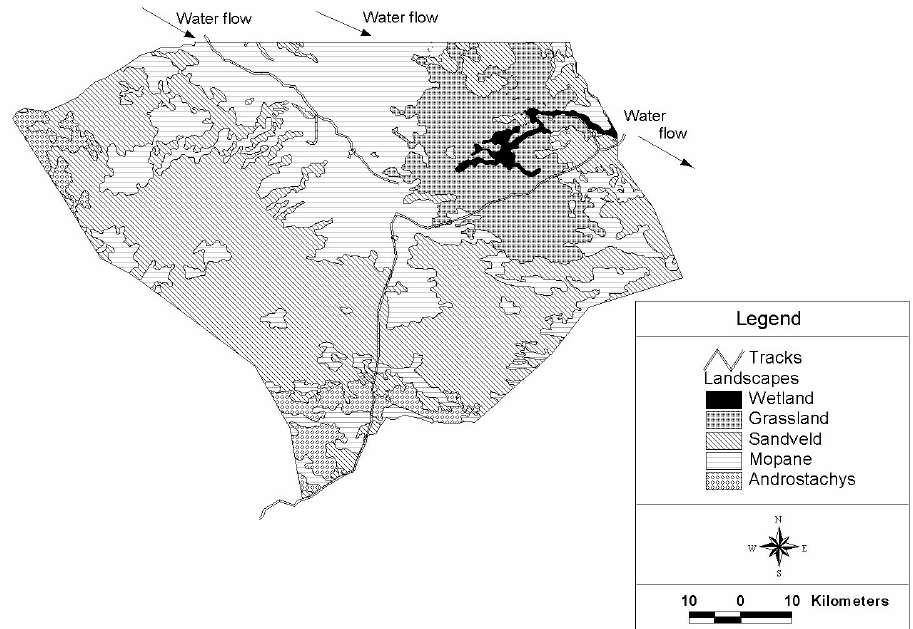
Fig. 7. Landscape map of the Parque Nacional de